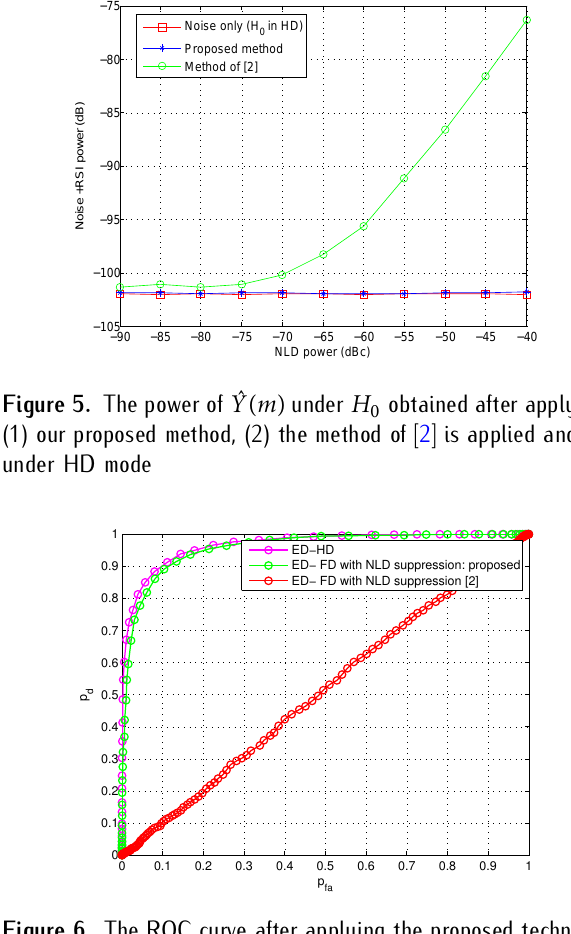
0 Figure 6. The ROC curve after applying the proposed technique of NLD suppression